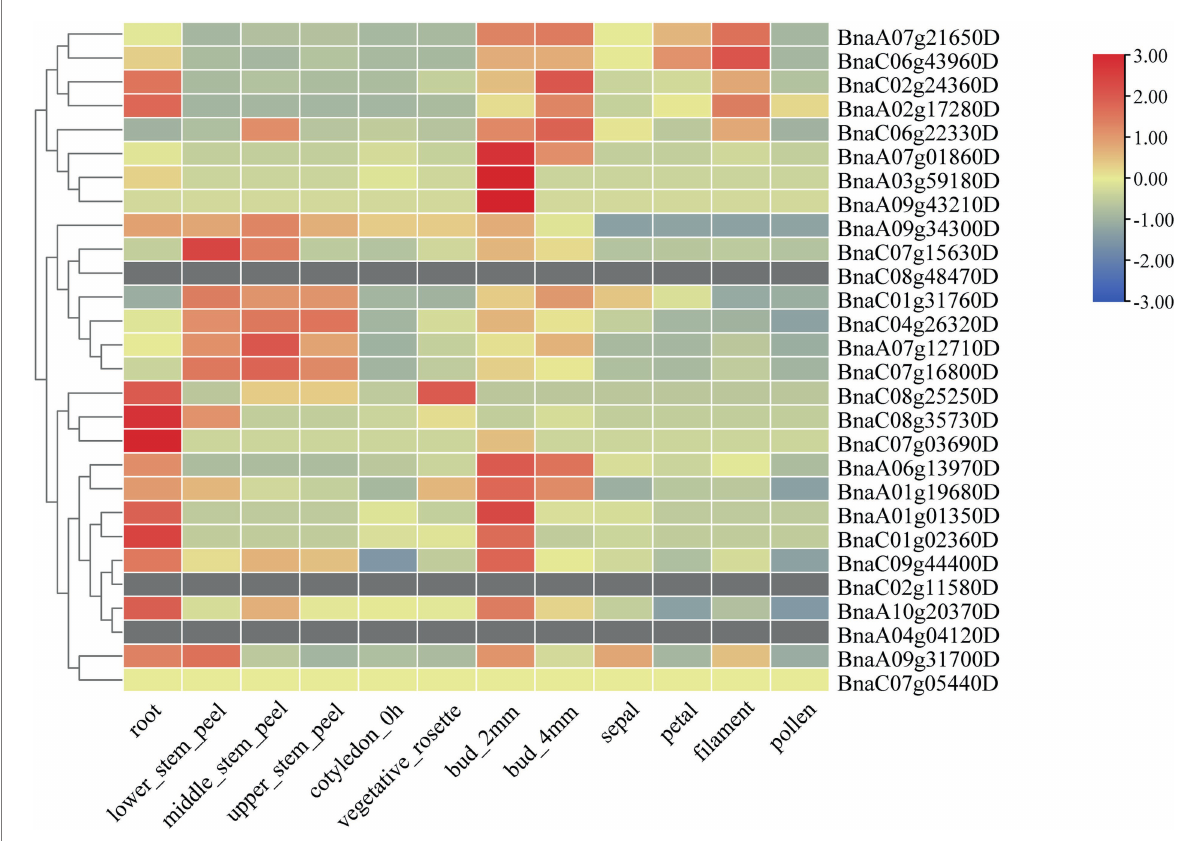
FIGURE 9 The expression patterns of BnSHI/STYs in different tissues. BnSHI/STYs are clustered by hierarchical clustering. The different color box represents expression quantity in different tissues, red to blue means expression lever from high to